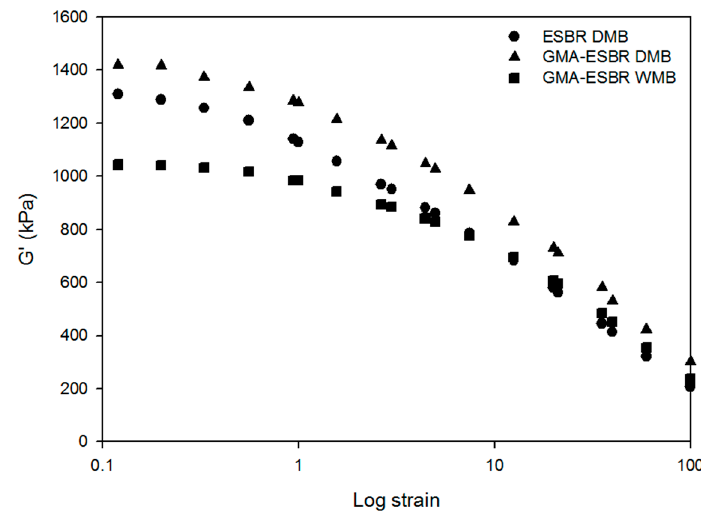
Table 6. The Payne effect ( Δ G’) of the ESBR DMB, GMA-ESBR DMB, and GMA-ESBR WMB compounds.